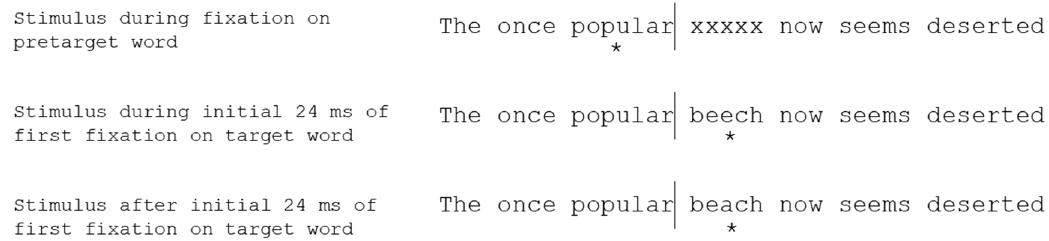
Figure 1. An example of the fast priming technique. The asterisk underneath each sentence indicates the reader’s fixation location. An invisible boundary is placed in a sentence in the space before a target word (the lines in the example above represent the location of the boundary, but this is not visible to participants). Before fixation, a string of xs is present where the target word should be. When the readers’ eyes cross the invisible boundary and first fixate the target word location, a prime is presented for a very brief amount of time (e.g., 24 ms), before being replaced by the target word. This example shows a homophone prime (e.g., beech ) for a target word (e.g., beach ).